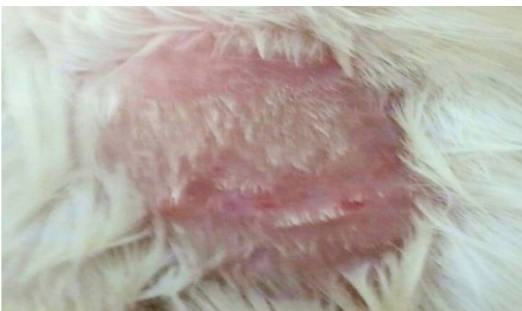
FIGURE 12(c ) - Mice skin for observation of erythema after 48